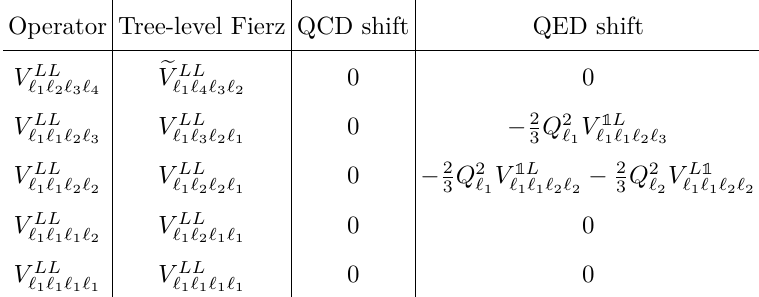
Table 3. Fierz transformations for four-lepton γ µ P L ⊗ γ µ P L operators together with their one-loop QCD and QED shifts in the original BMU scheme.